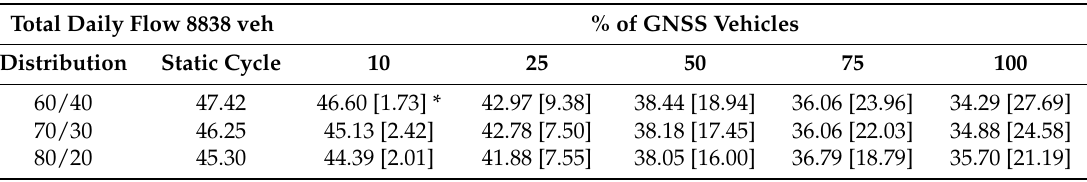
Table 3. Average travel time [sec.], in a typical day, for Case A.